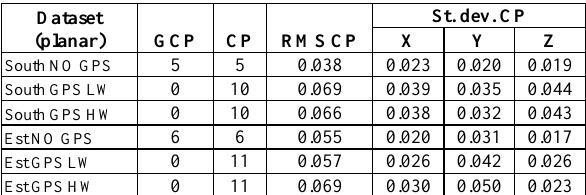
Table 15. Planar dataset: stats on residuals [m].